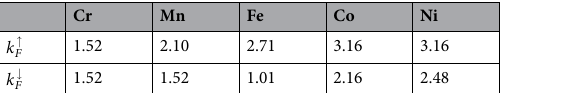
( ) (in the units of − a 1 ) from the band structures in all considered 3 d F lat